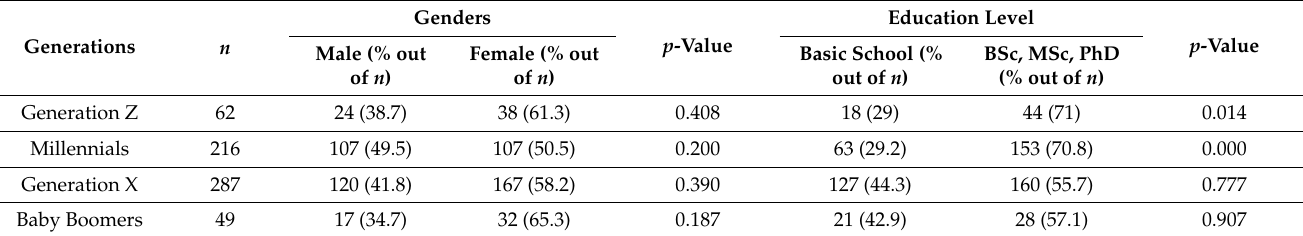
Table 1. Genders and education level amongst generations, n =